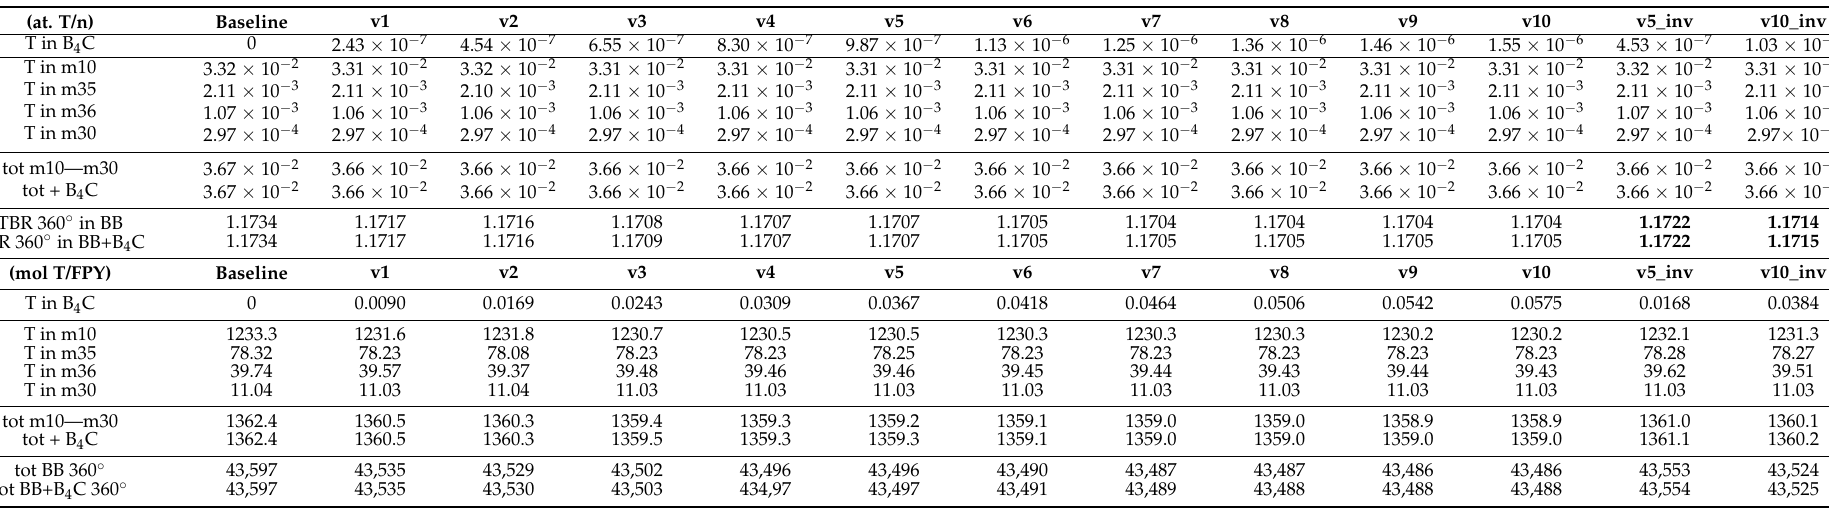
Table 7. Tritium production at the B 4 C shield and the rest of the BB structures for the baseline model, versions v1–v10, and v5_inverted and v10_inverted configurations. The material numbering used in the MCNP input is maintained in this